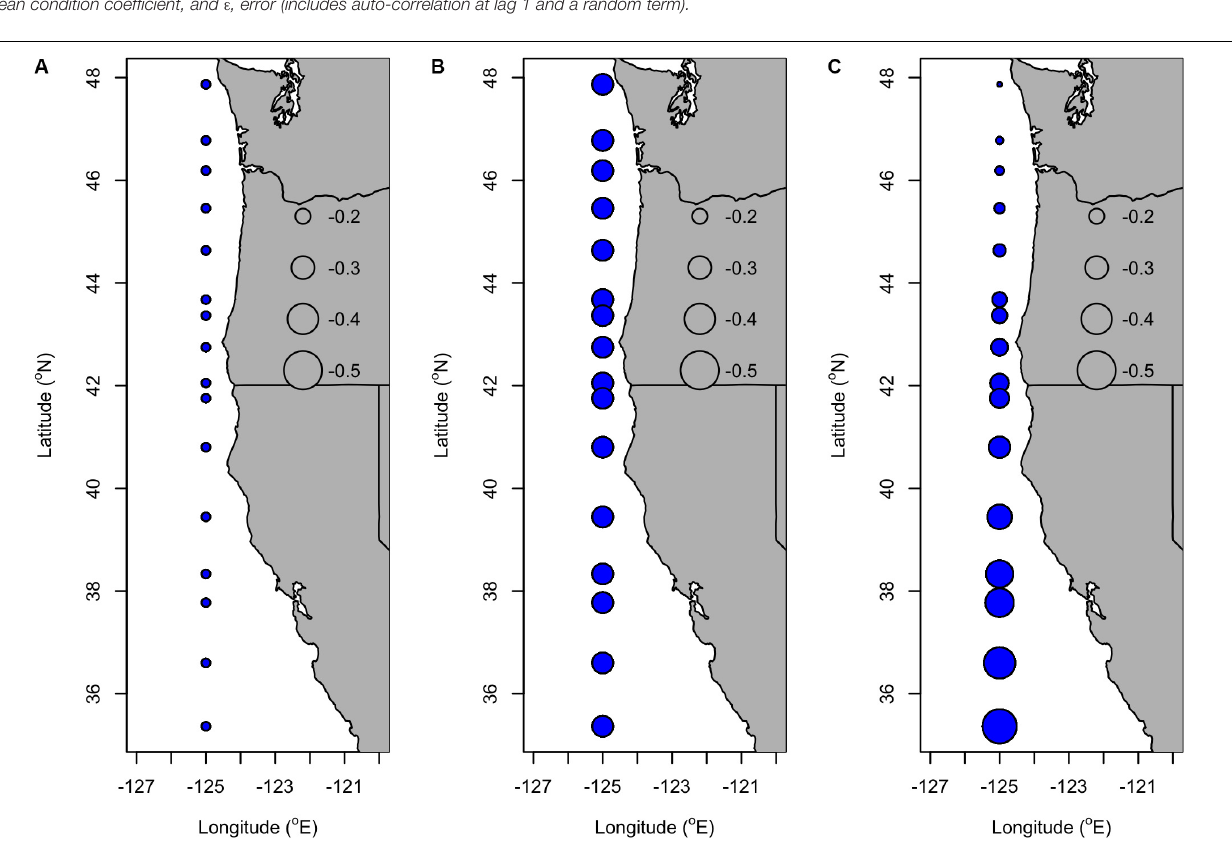
FIGURE 5 | Coefficients of SST lagged by (A) 3 years, (B) 4 years, and (C) 5 years in the selected VC_GAMM of Dungeness crab commercial ln(CPUE) along the U.S. west coast ( Table 3 ). The latitude of ports corresponding to each of the circular symbols are listed in Table 4 . Blue symbols represent negative coefficients and the size of the symbol scales with the magnitude of the